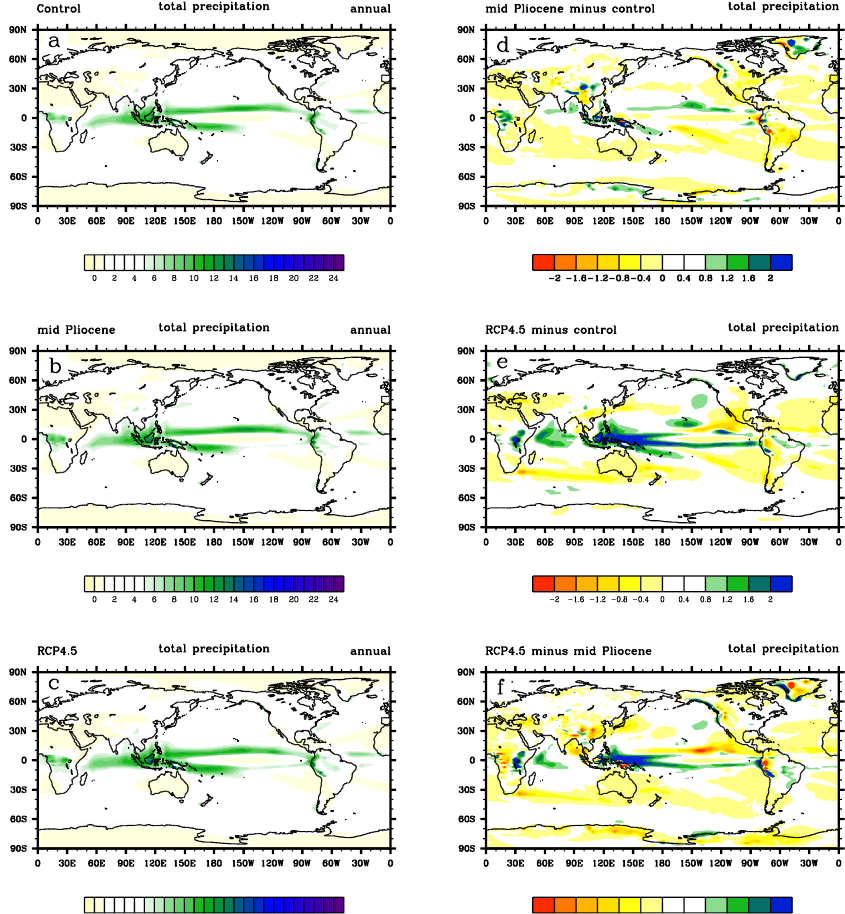
Fig. 9. Simulated annual mean total precipitation (units: mmday − 1 ) from (a) the control run, (b) the mid-Pliocene warm period and (c) the RCP4.5 scenario. Simulated responses of the total precipitation to mid-Pliocene (d) and future warm climate (e) , and total precipitation Fig. 9 Simulated annual mean total precipitation (units: mm/day) from (a) the control 3 difference between the RCP4.5 and mid-Pliocene (f) are displayed in (d–f) , run, (b) mid-Pliocene warm period and (c) RCP4.5 scenario. Simulated responses of 4 the total precipitation to mid-Pliocene (d) and future warm climate (e) , total 5 precipitation difference between the RCP4.5 and mid-Pliocene (f) are displayed in 6 (d-f), respectively. 7